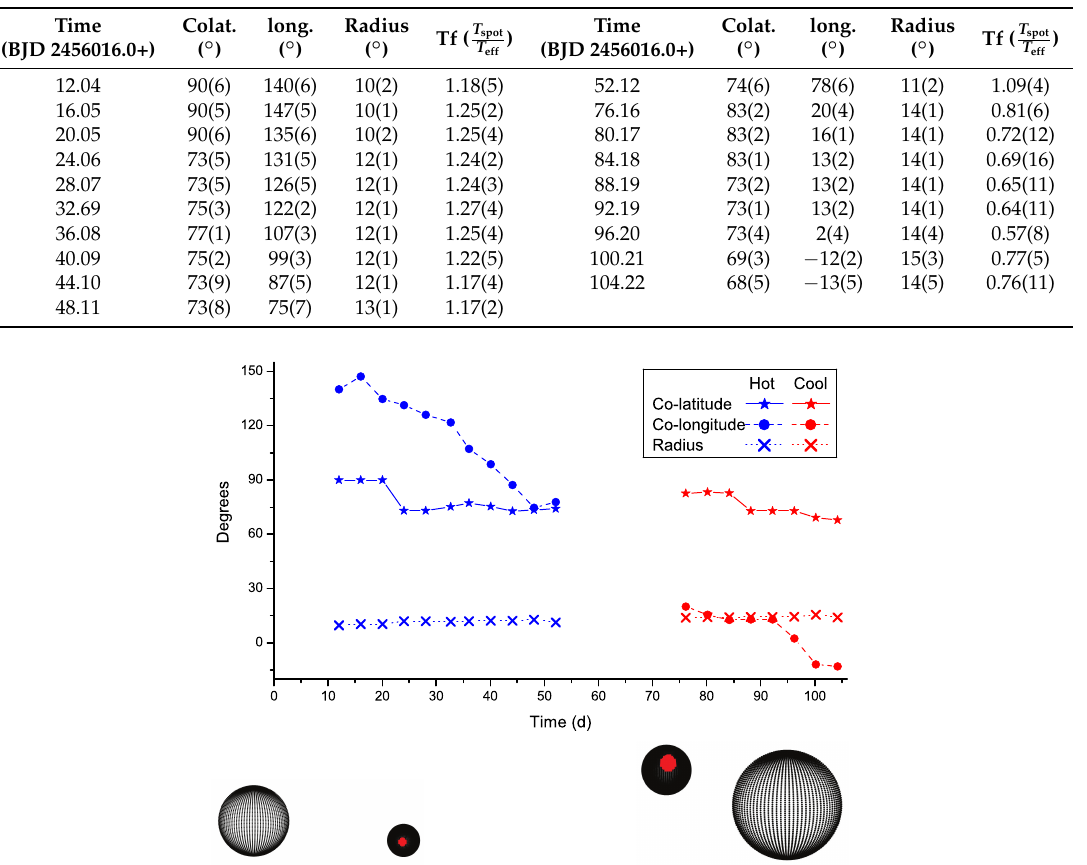
Figure A1. Top panel: Spot migration diagram for KIC 8504570. Lower left panel shows the hot spot on the surface of the secondary at orbital phase 0.10 during the 12th day, and the lower right panel illustrates the cool spot on the same component at an orbital phase of 0.55 during the 104th day of